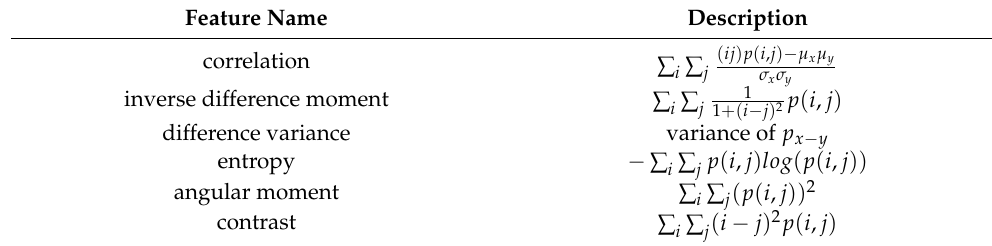
Table 2. The local texture-feature-based GLCM matrix